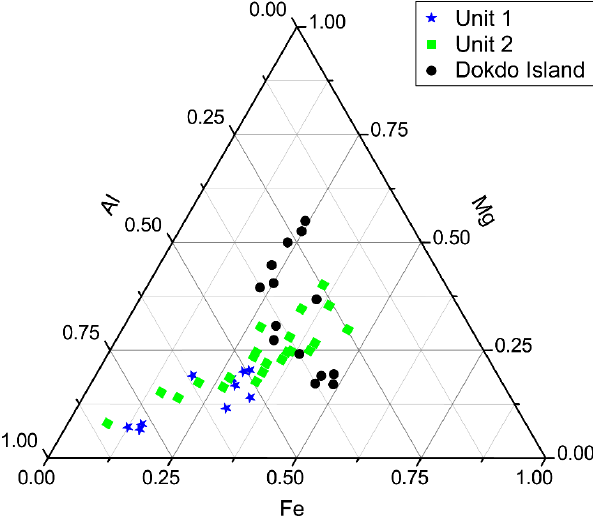
Figure 5. The Selected Smectites Samples with TEM Micrographs. ( a ) Unit 1 (interglacial period) samples with SAED patterns, ( b ) Unit 2 (late glacial period) samples with SAED patterns, and ( c ) Dokdo Island samples with SAED patterns.